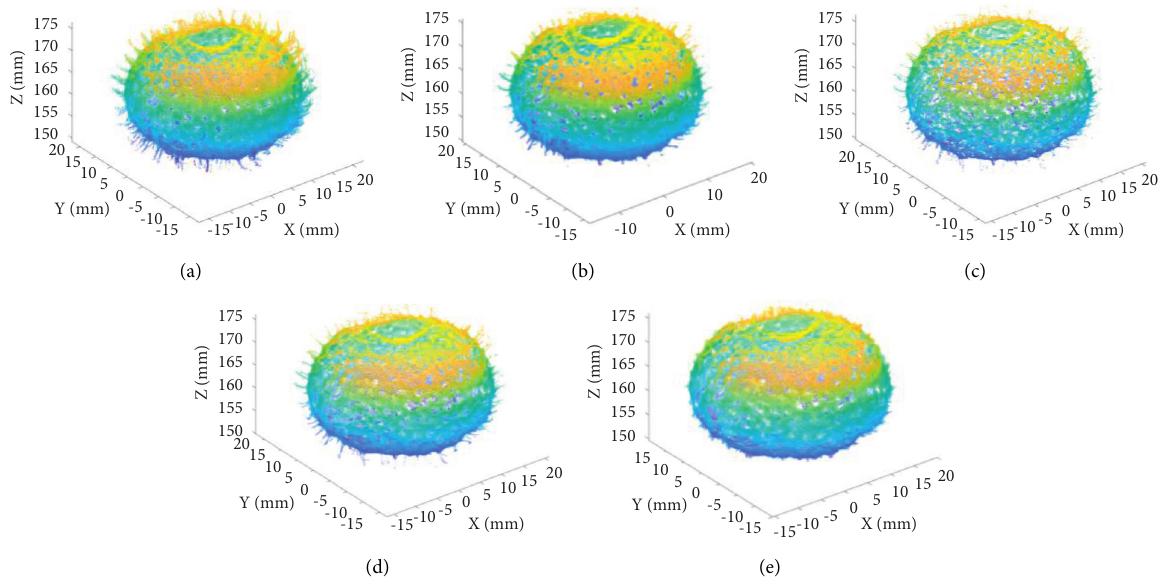
Figure 7: Original 3D point cloud and result of point cloud segmentation. (a) Original point cloud; (b) statistical outlier removal; (c) radius outlier removal; (d) bilateral filtering; (e) proposed